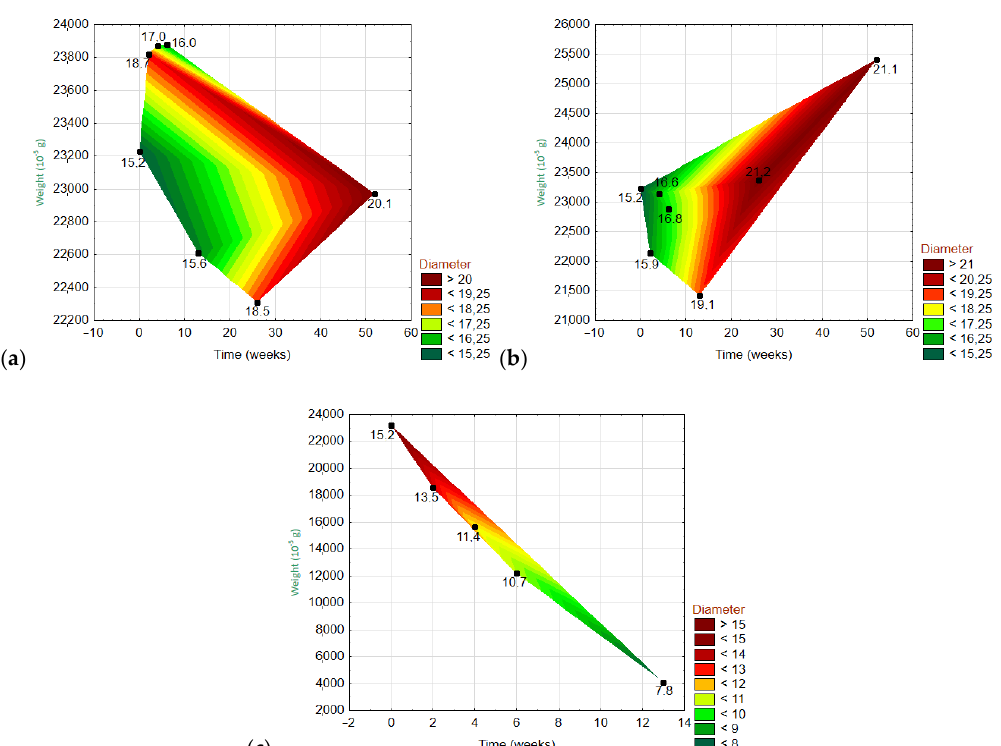
Figure 12. Three-dimensional wafer plots showing the dependencies of the three variables (diame- ter, weight, and time) for ARGFs treated with different solutions: ( a ) H 2 O, ( b ) Ca(OH) 2 , and ( c ) K 2 SiO 3 (bottom).